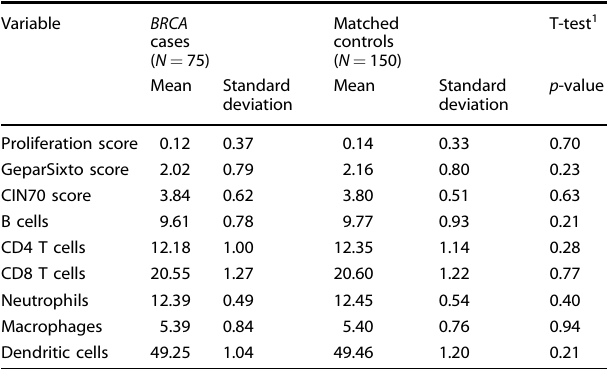
Table 4. Logistic regression for pathologic complete response by subtype and proliferation, GeparSixto, and CIN70